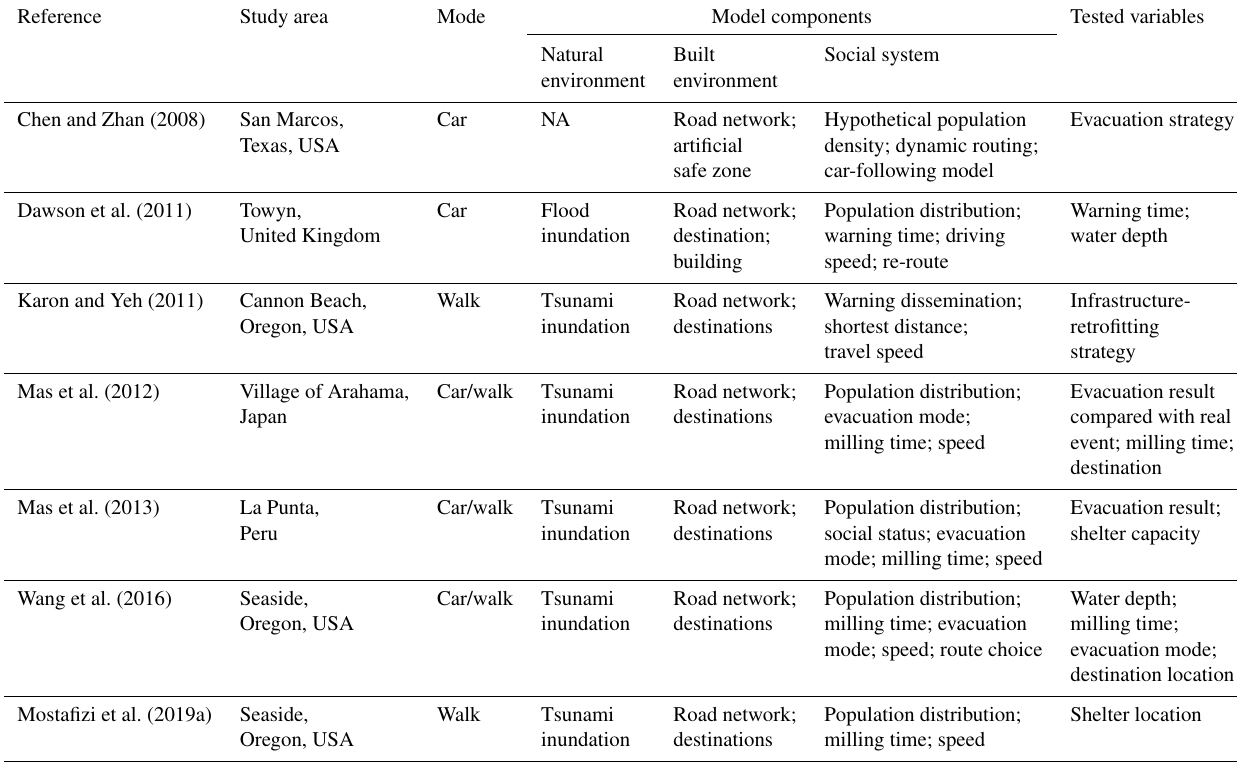
Table 1. Recent earthquake and tsunami ABMS